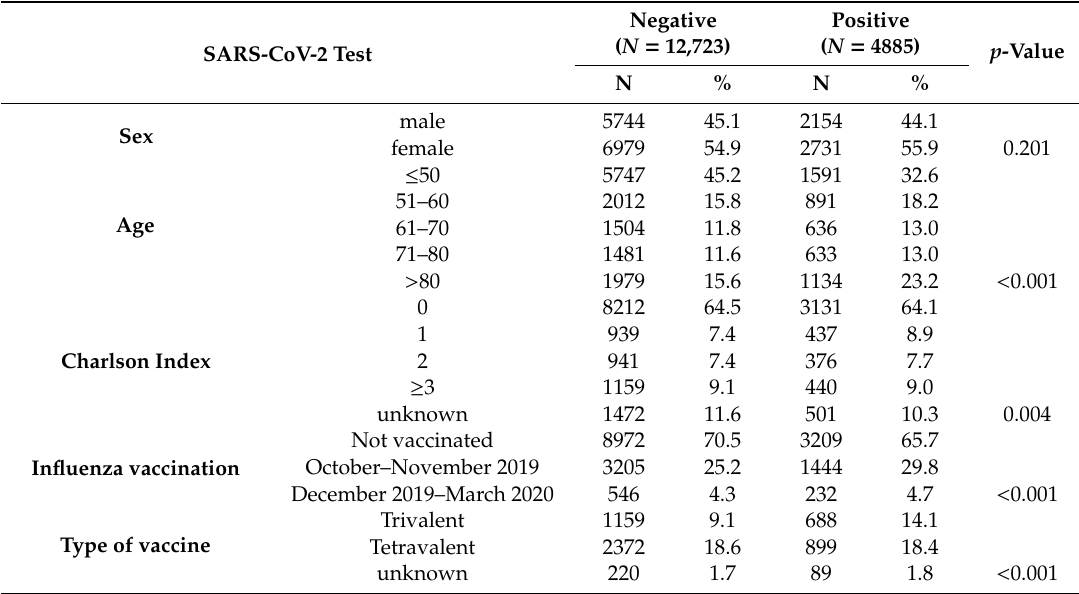
Table 1. Characteristics of residents in the Italian province of Reggio Emilia undergoing SARS-CoV-2 swab test from pandemic inception to 22 May 2020, according to swab test